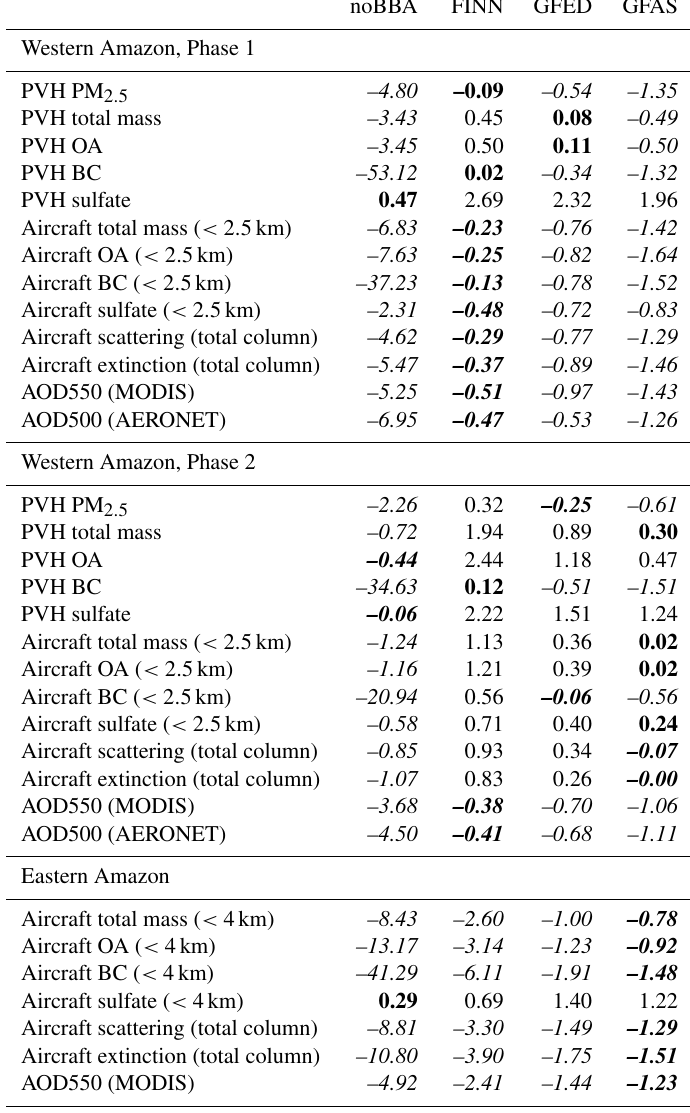
Table 2. Summary of comparison between the model and observations expressed as normalised mean bias factor (NMBF, italics indicates model underestimation). Comparisons are shown for observations from the Porto Velho measurement station (PVH): PM 2 . 5 (particulate mat- ter with diameters smaller than 2.5µm) mass; total aerosol mass (mass measured by the ACSM plus equivalent black carbon measured by the aethalometer); and organic aerosol (OA), black carbon (BC), and sulfate mass concentrations. Comparisons are shown from the aircraft: total aerosol mass (mass measured by AMS plus refractive BC measured by the SP2) and OA, BC, and sulfate mass concentrations; aerosol scatter- ing; and aerosol extinction. Comparisons are shown from the satellite: aerosol optical depth at 550nm (AOD550) from MODIS and AOD500 from AERONET. Aircraft comparisons are for concentrations below 2.5km (western Amazon) or 4km (eastern Amazon). AERONET com- parisons are the average NMBF across five stations. For aircraft total aerosol mass, scattering and extinction, the model and observations are compared only during time periods with available AMS measurements. Values are shown for the model with FINN1.5, GFAS1.2, GFED4.1s emissions and with no biomass burning emissions (noBBA). The numbers highlighted in bold show the model simulation with the smallest